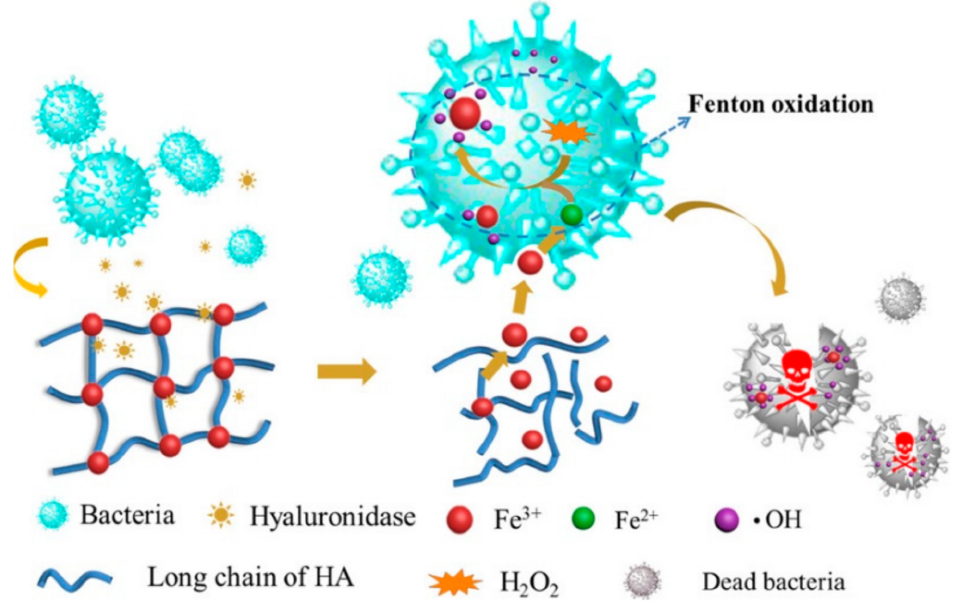
Figure 9. Sustained release effects of Fe 3+ loaded SHH. SHH: Fe 3+ -HA complex was rapidly adsorbed by bacteria and subsequently caused the reduction of Fe 3+ to Fe 2+ . Fe 2+ reacts with H 2 O 2 to generate hydroxyl radical (.OH) which damages the bacterial proteins or nuclear acids. This figure is reprinted from Tian et al. [156]. “This study is under Creative Commons Attribution 4.0 International License, which permits use, sharing, adaptation, distribution, and reproduction in any medium or